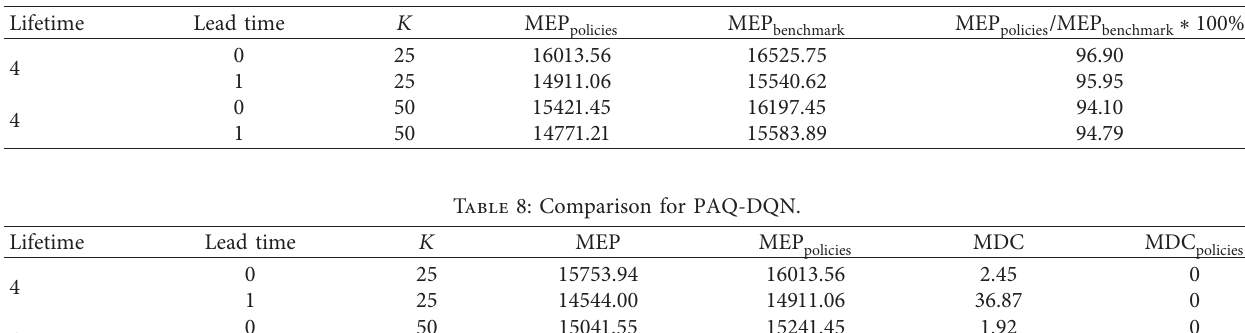
Table 7: MEP for the learned policies.